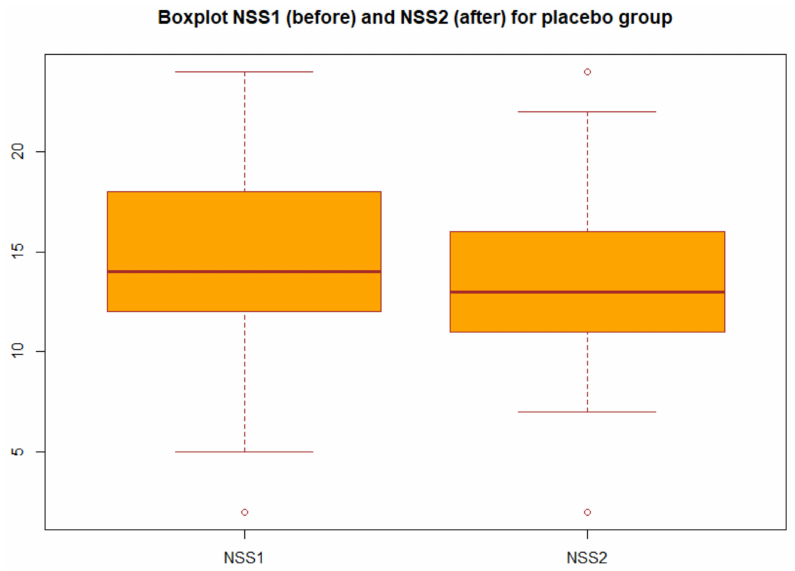
Figure 2. Boxplot of NSS before and after treatment in the placebo group (group